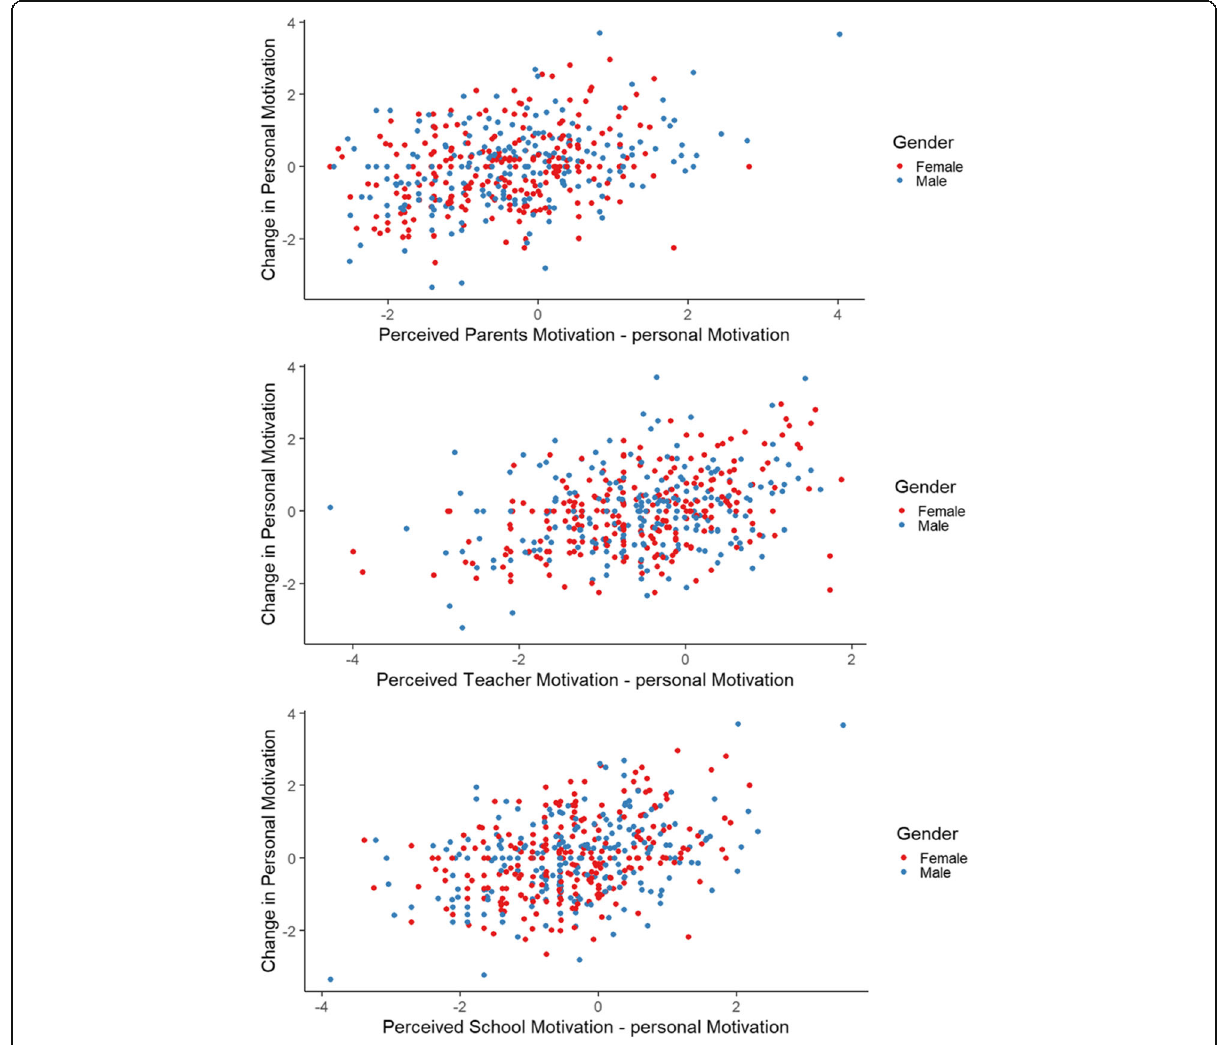
Fig. 2 Changes to personal MAOTS vs. difference between perceived environmental emphases on MAOTS and personal